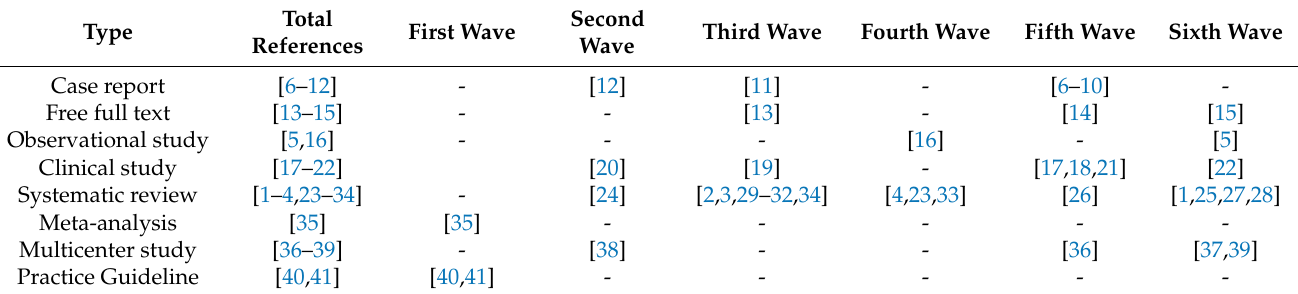
Table 1. Total references selected and classified by the pandemic